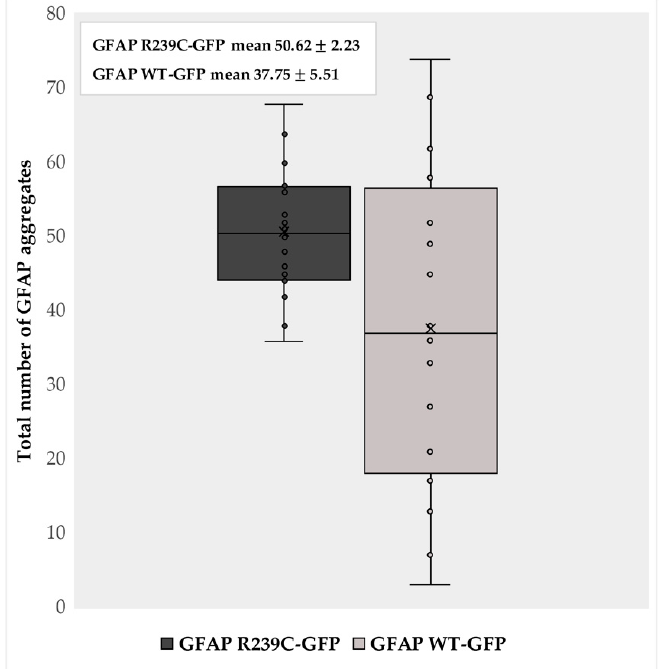
Figure 2. Aggregate quantification. The box plot represents the number of aggregates detected in 16 GFAP R239C-GFP embryos and in 16 GFAP WT-GFP embryos at 24 h post fertilization (hpf). The “x” indicates the average values of 50.62 and 37.75 aggregates in p.R239C and wildtype embryos, with a standard error of the mean (SEM) of ± 2.23 and ± 5.51, respectively. The count of the aggregates was made using ImageJ software 1.52q.